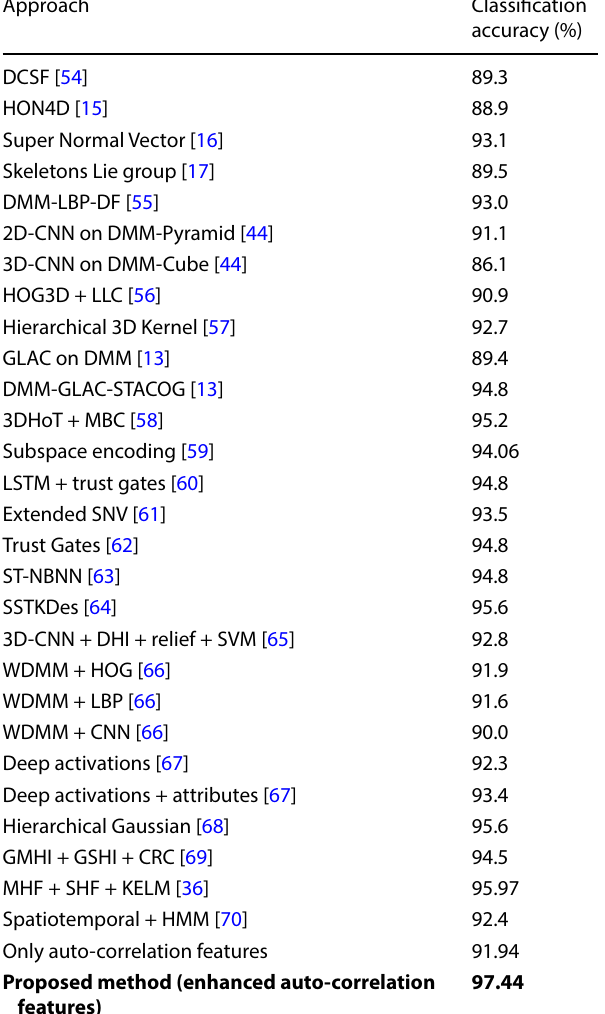
Table 1 Performance of our method compared to the existing sys- tems in terms of the MSRAction3D dataset